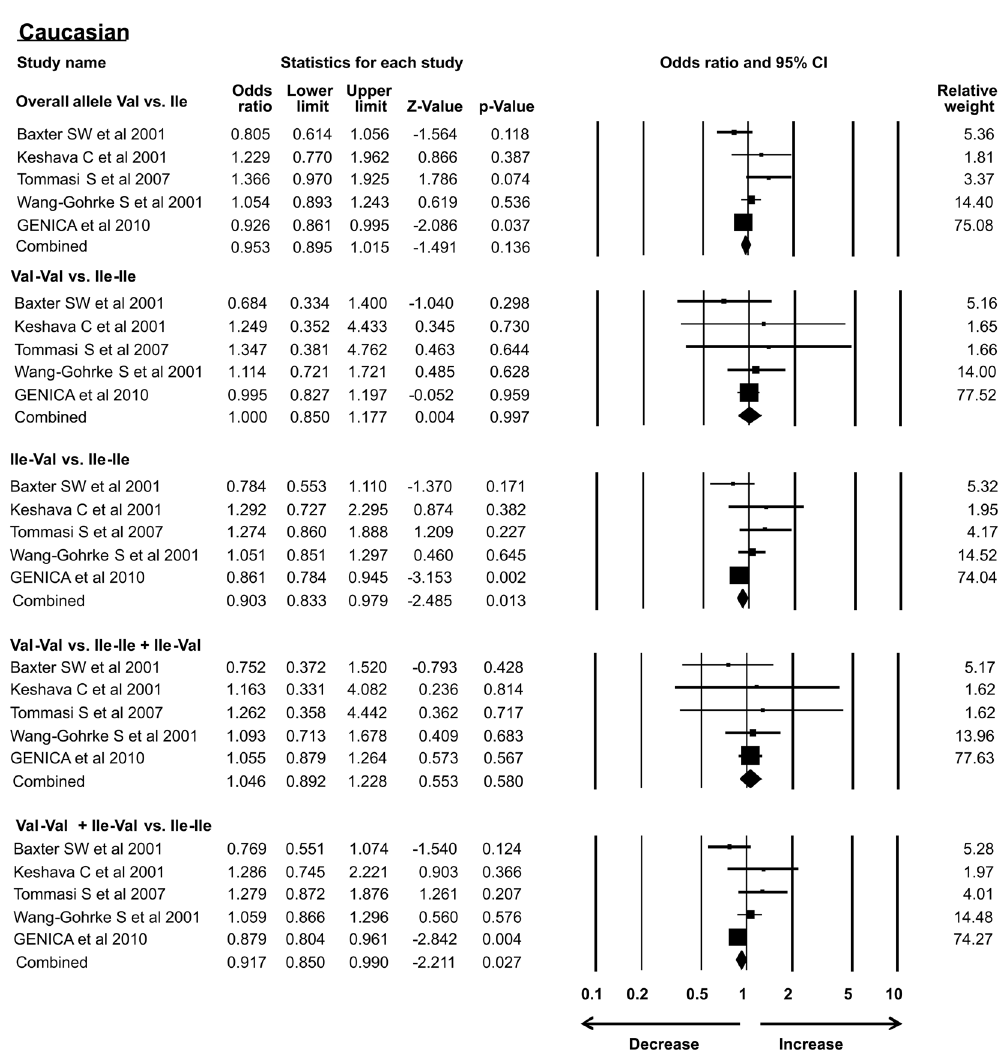
Figure 7. Forest plot: Analysis of Her2 Ile 655 Val (rs1136201) gene polymorphism data from Caucasian ethnic group and validation of its correlation with breast cancer susceptibility using OR with 95% CI. Black squares represent the value of OR and horizontal line indicates 95% Confidence Interval (CI) of odds ratio